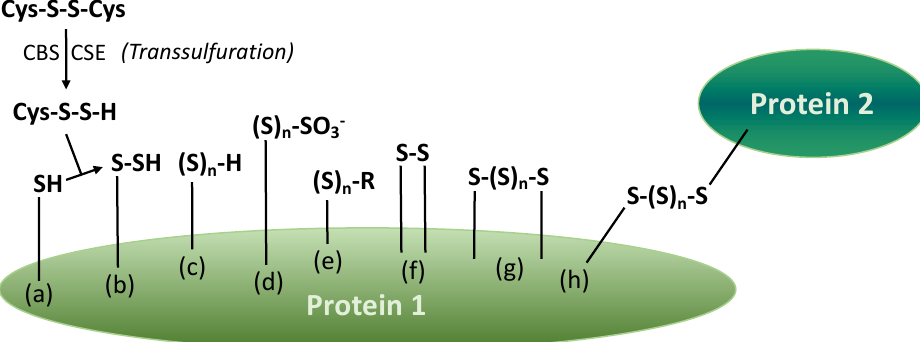
Figure 7. Products of protein (enzyme) transsulfuration and consecutive reactions (based on [27]). Legends: ( a ) cysteine in protein 1 (transsulfuration by cysteine persulfide); ( b ) protein persulfide; ( c ) protein monosubstituted polysulfane; ( d ) protein polysulfane monosulfonic acid; ( e )